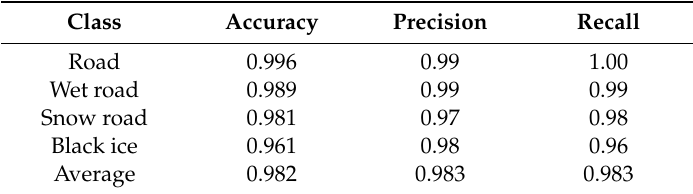
Table 10. Accuracy, precision, recall results by class.